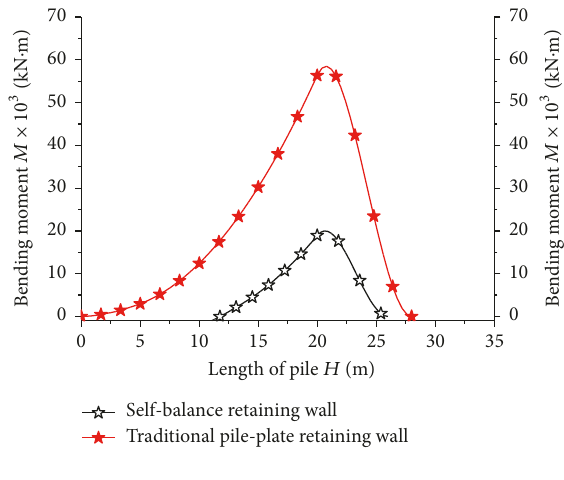
Figure 8: The pile bending moment diagram.